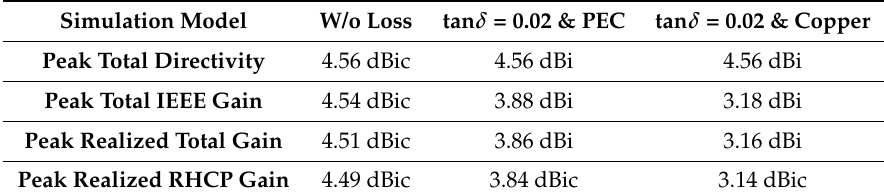
Table 1. Loss origins for the proposed structure.